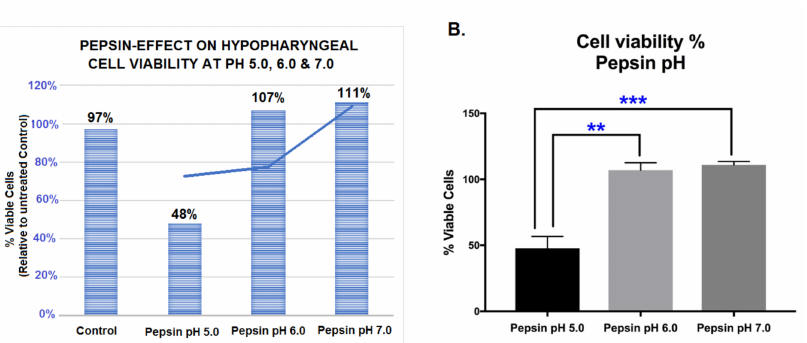
Figure 1. The pepsin-effect on cell viability of human hypopharyngeal primary cells (HCs) exposed to weakly acidic pH 5.0, slightly acidic pH 6.0 and neutral pH 7.0. ( A ). Graphs depict the viability rates in HCs exposed to control (media at pH 7.0) and pepsin at pH 5.0, 6.0 and pH 7.0 (% of viable HCs in pepsin and control-treated groups vs. untreated control). ( B ). Graph depicts differences in the viability of HCs treated with pepsin at pH 5.0, 6.0 and 7.0 (pepsin treated vs. control-treated HCs). Graphs, created by GraphPad Prism 7 software; ** p < 0.005; *** p < 0.0005, by t -test; multiple comparisons by Holm-Sidak). (Data are derived from three independent